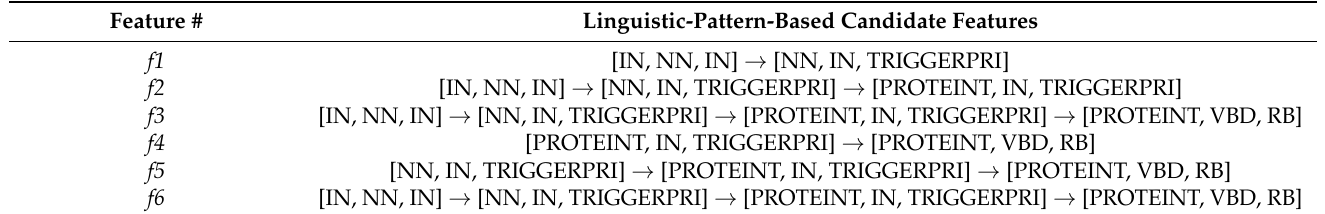
Table 6. Candidate feature representation developed for classification